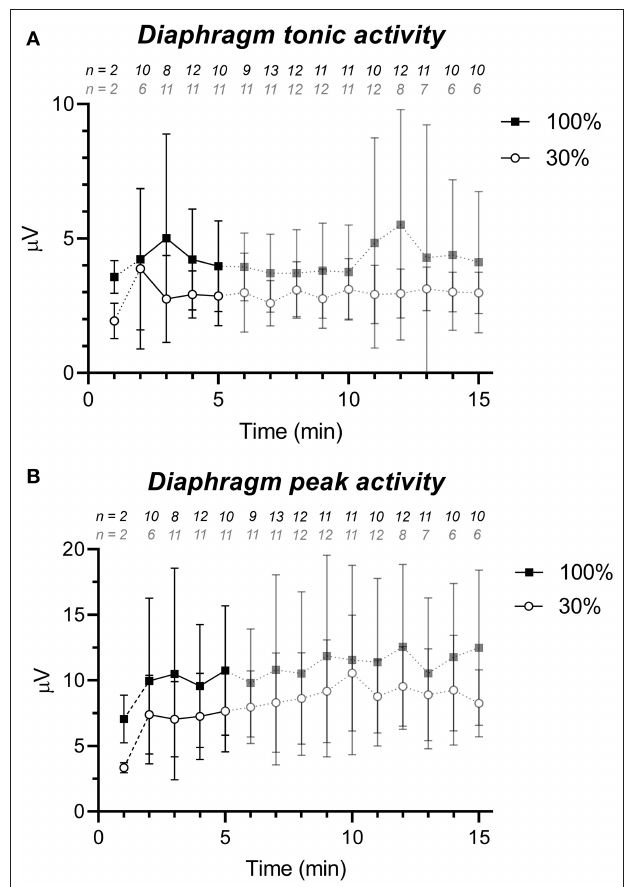
FIGURE 1 | dEMG signal strength parameters (mean ± standard deviation) for the 30% (white circles) and 100% group (black squares) showing a higher level of diaphragm activity in the 100% group. (A) tonic diaphragm activity and (B) peak diaphragm activity. The first line piece is dashed, due to the low sample size directly after birth. Data after 5min is semi-transparent as this data was not taken into account in the statistical analysis. The numbers above the graph represent the number of infants of which dEMG data was available (after artifact removal) for that particular minute and